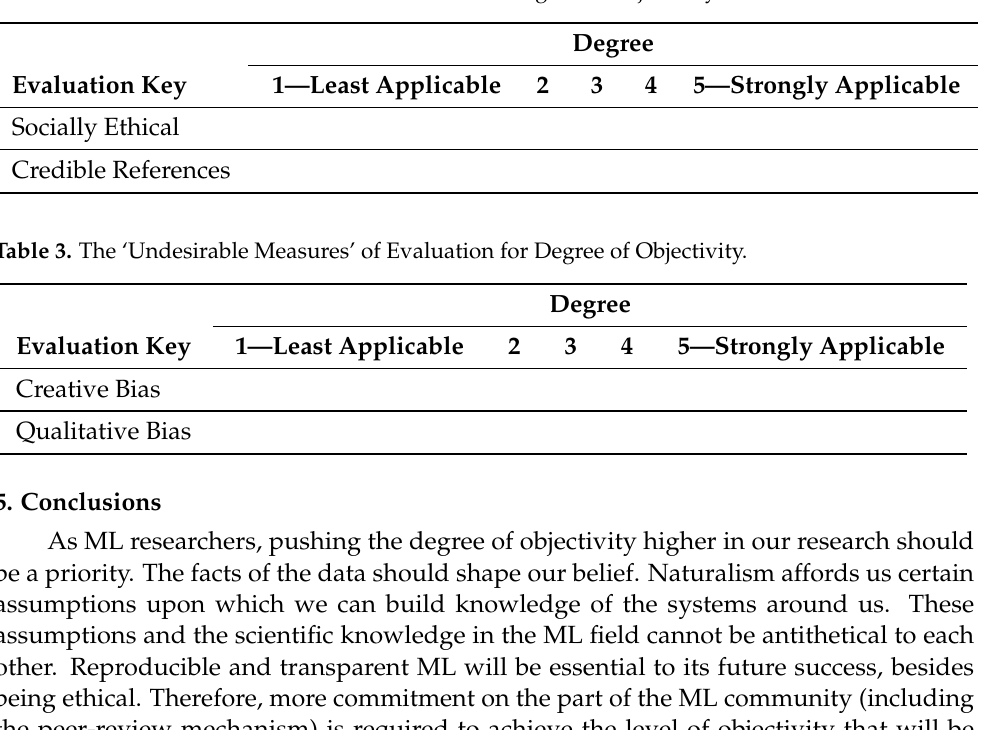
Table 2. The ‘Desirable Measures’ of Evaluation for Degree of Objectivity.